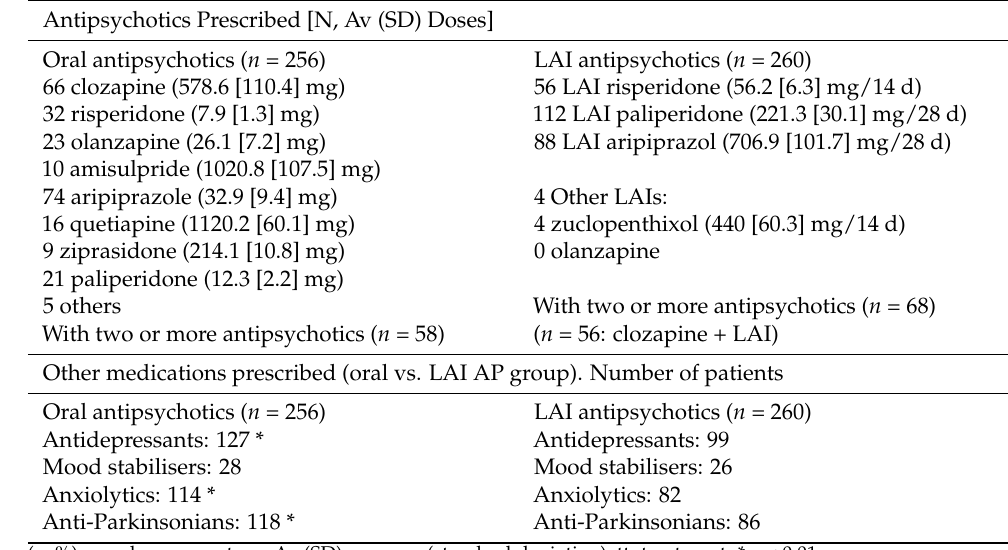
Table 2. Antipsychotics and other medications